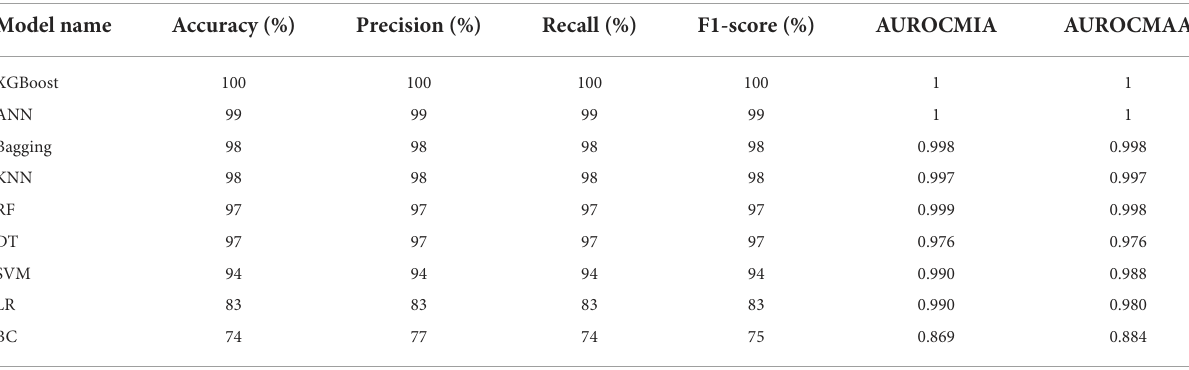
Model evaluation